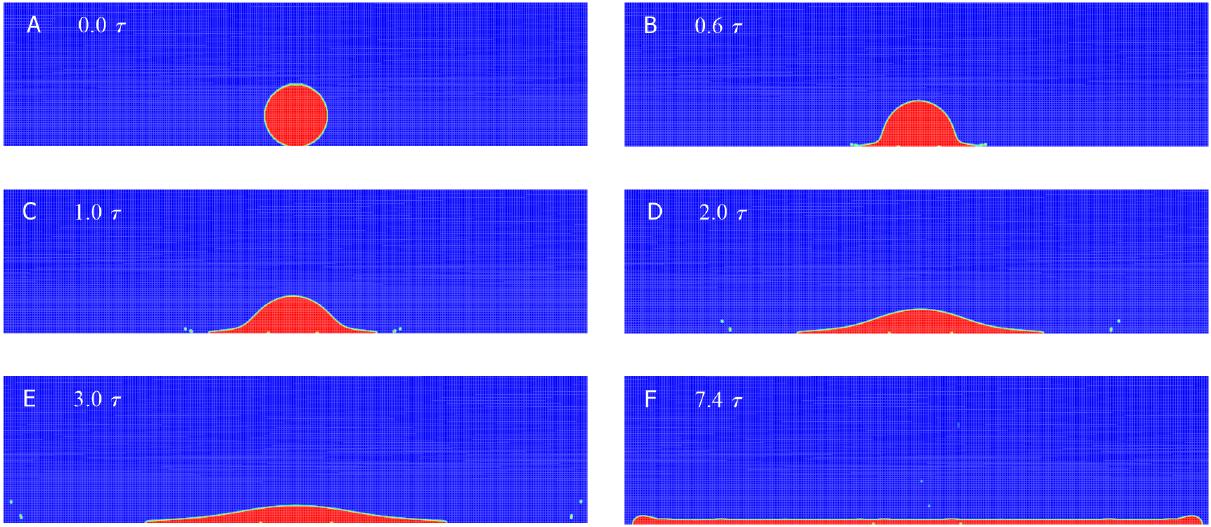
Fig 3. Droplet volume fraction during an impact. Volumefraction contours for a viscous silicone oil drop with diameter of 1.6 mm impactingat 4 m/s onto a smooth dry solid surface under the surroundingpressure of 34 kPa. The successive times are t = 0, 0.6 τ , τ , 2 τ , 3 τ and 7.4 τ where τ (cid:17) a / U 0 is the characteristic time of impact, as listed in order from A to F.